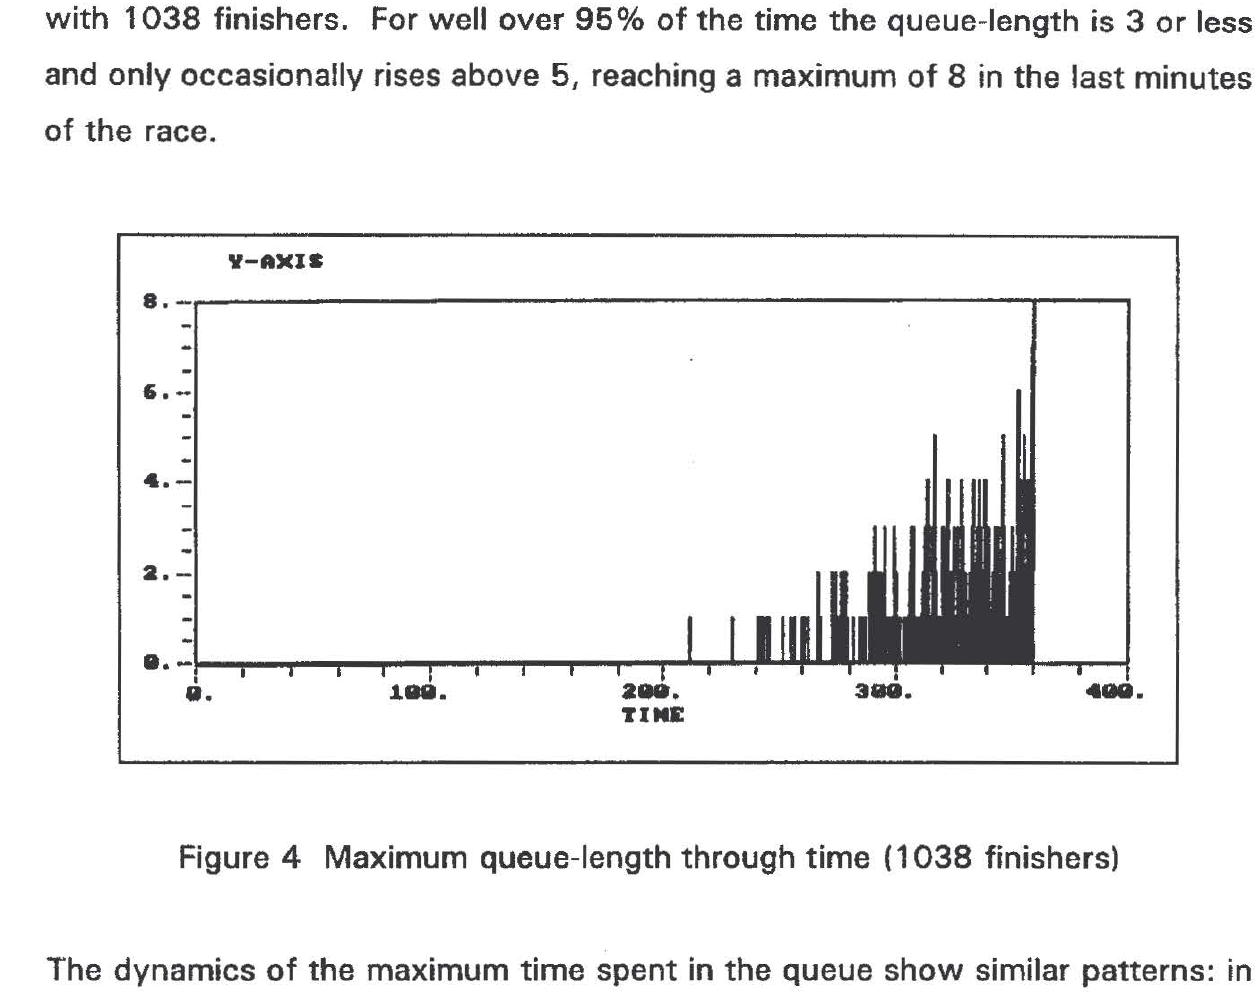
Figure 4 Maximum queue-length through time ( 1 038